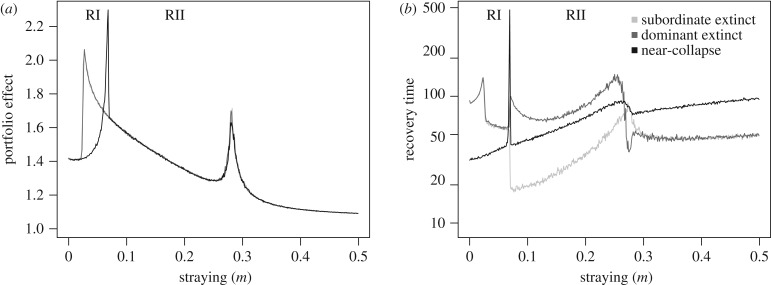
Measures of metapopulation robustness for the constant straying model as a function of straying m. Alternative stable state regimes I and II corresponding to those in figure 1 are labelled RI and RII, respectively. (a) Portfolio effect as a function of m. (b) Recovery time as a function of m. Measures of metapopulation robustness are shown with respect to different induced disturbances: the near-collapse of both populations (black), and the lone extinction of either the dominant (dark grey) or subordinate (light grey) population. Portfolio effects are different for the near-collapse and single extinction scenarios due to different CVs for the populations and aggregate in alternative basins of attraction that exist in regimes I and II.